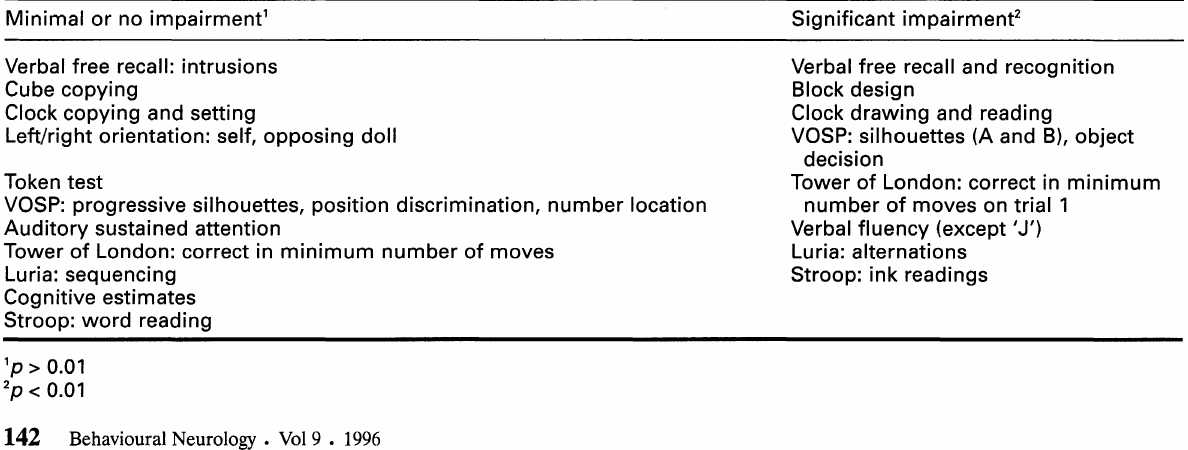
TABLE IV. Classification of test results into measures showing minimal, or no impairment, or significant impairment in mild OAT patients relative to normal elderly controls Minimal or no